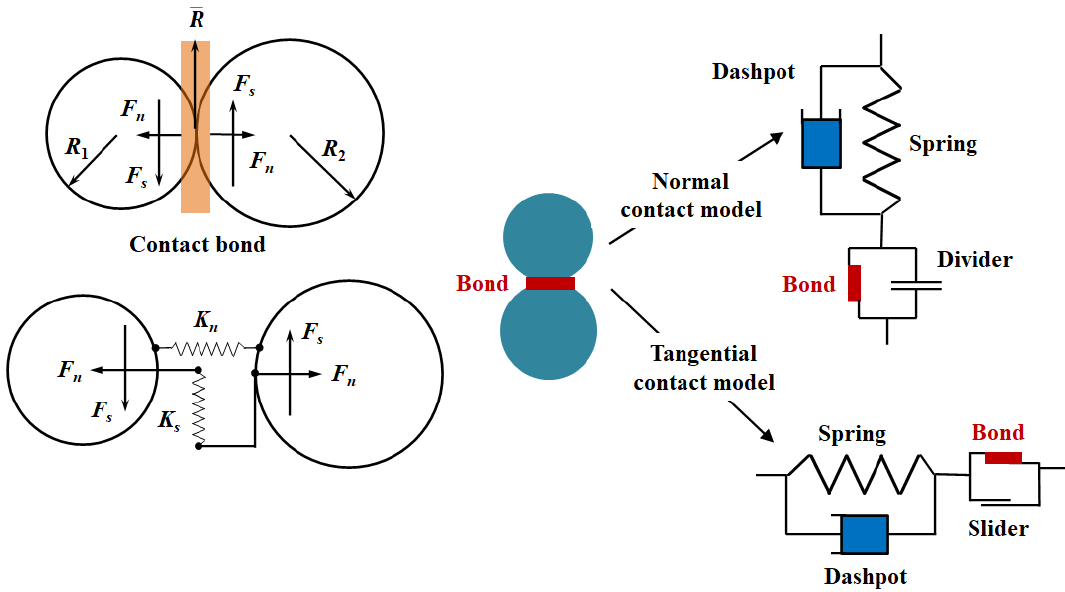
Figure 1. Mechanical behavior of parallel bond model based on [23].